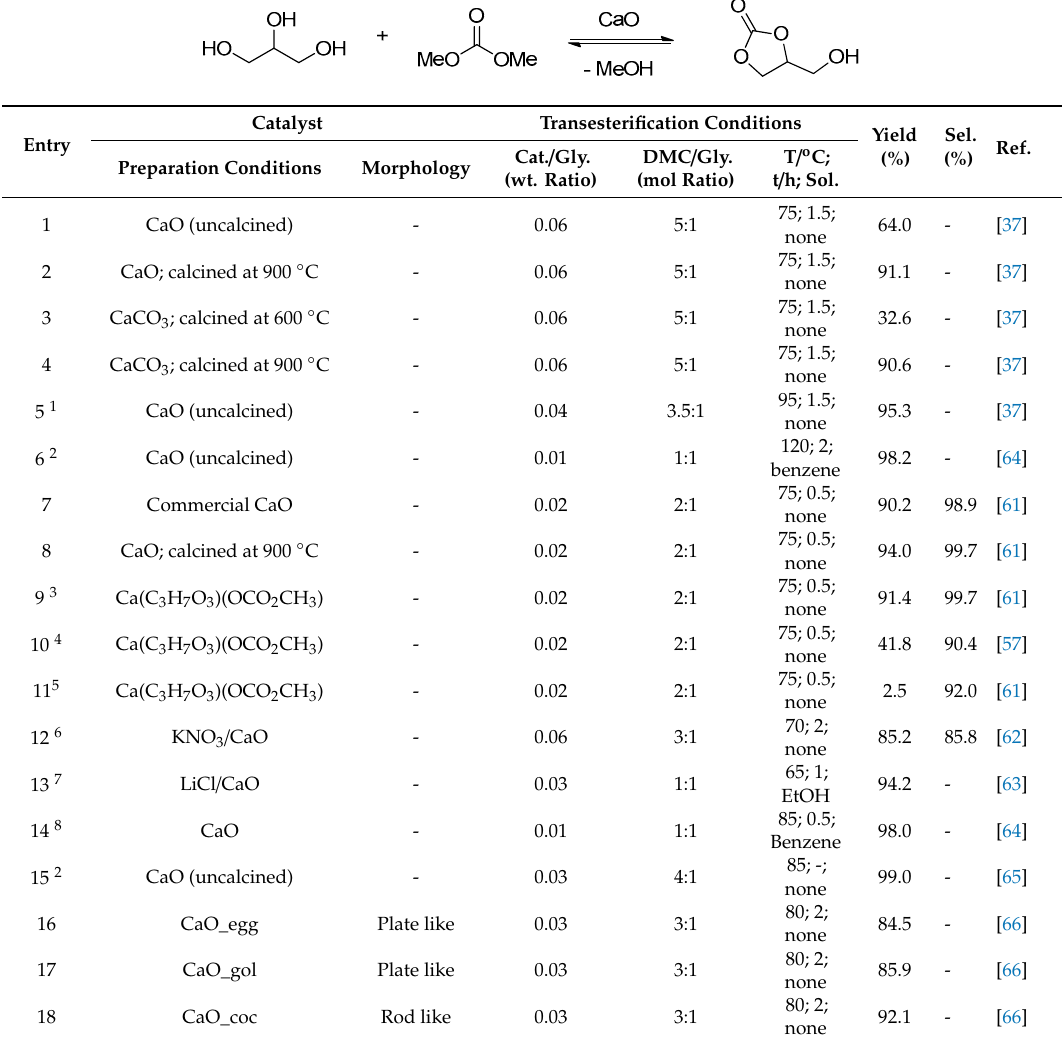
Table 2. CaO-catalyzed transesterification of glycerol.